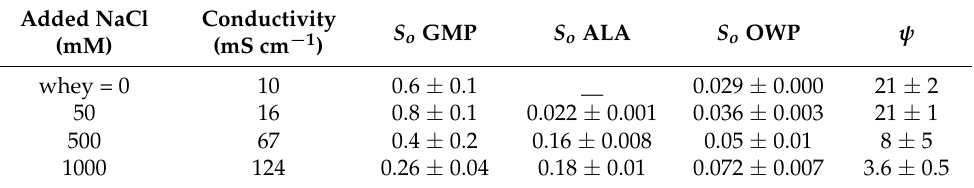
Table 2. Effect of added salt on the sieving coefficients ( S o ) of GMP, alpha-lactalbumin (ALA), and the OWP, and the GMP-OWP selectivity ( ψ ) using whey at pH 3.5 and 22 ◦ C, and a permeate